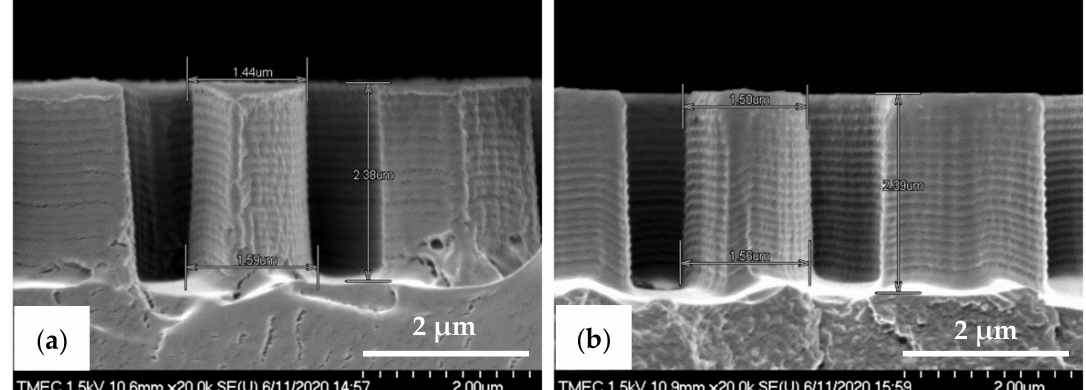
Figure 16. Cross-sectional view SEM images with corresponding measured dimensions of the C-RESS micro-structure (pattern design: size: 1.5 µ m, space: 0.5 µ m, height: 2.5 µ m) replicated by R2P NIL process ( a ) imprint on PC foil with resin A (C-RESS-A) and ( b ) imprint on PC foil with resin B